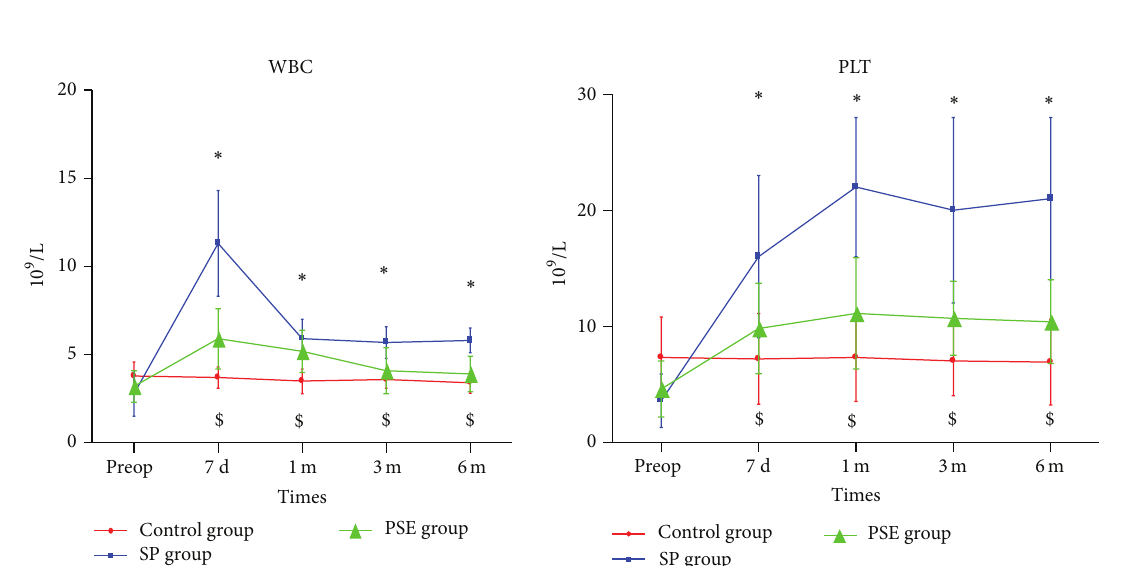
Figure 2: The preoperative and serial postoperative measurements of WBC and PLT counts. ( ∗ indicates significant difference compared with the baseline in the PSE group, 𝑃 < 0.05 ; $ indicates significant difference compared with the baseline in the SP group, 𝑃 < 0.05 .)